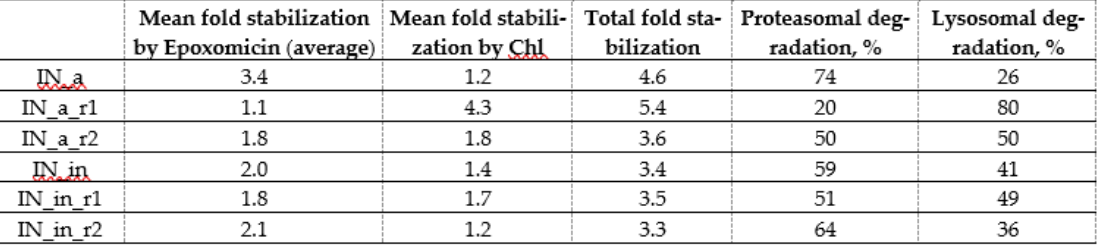
Figure 3. Proteolytic degradation of IN variants. Half-life of IN variants determined by pulse-chase ( a ); degradation pathway probed using proteasome ( b ) and Lysosome ( c ) inhibitors; proportion of proteasomal and lysosomal degradation patterns in the overall IN degradation ( d ). HeLa cells were transiently transfected with pVaxIN_a, or pVaxIN_a_r1, or pVaxIN_a_r2, or pVaxIN_in, or pVaxIN_in_r1, or pVaxIN_in_r2, and subjected to cycloheximide chase to determine half-life ( a ), or 48 h post-transfection treated with proteasome inhibitors MG132 (10 µ M) or Epo (0.5 µ M) ( b ), or lysosome inhibitors chloroquine (Chl; 10 µ M), leupeptin (Leu; 10 µ g/mL), aprotinin (Apr; 100 µ g/mL), pepstatin (Pep; 5 µ g/mL), or E-64 (10 µ М ), or left untreated (“Untr”) ( c ). Graphs ( b , c ) demonstrate the relative amount of IN protein in samples incubated with MG132 and epoxomicin ( b ) or with chloroquine (( c ), left panel) or with inhibitors of individual classes of proteases active in the lysosomal compartment represented as a pile-up of the effects of individual inhibitors (( c ), right panel) compared to the untreated samples. ( d ) Size of the circles is proportional to the total increase in the content of IN variants achieved after application of proteasome (Epo) and lysosome (Chl) inhibitors (total fold stabilization). Sectors of the circles show contributions of Epo and Chl inhibitors to the total stabilization of each IN variant, in %. The values used for the plotting of pie diagrams are indicated in the table below. Data represent the results of at least three independent experiments. IN variants demonstrated no significant difference in half-life in the CHI ( a ), or in response to treatment with MG132 versus Epoxomicin ( b ), or in response to treatment with Chl as compared to sum of treatments with individual inhibitors of lysosomal proteases ( c ) ( p > 0.05, Mann–Whitney test). *— p < 0.05, **— p < 0.01, difference between individual IN variants indicated on ( b , c ). The differences that were not shown on the ( c ) for the IN variants treated with Chl: IN_a_r2 versus IN_in_r2, p < 0.05; [IN_a, IN_in, and IN_in_r2] versus [IN_a_r1, IN_a_r2, and IN_in_r1], p < 0.01; IN_a_r1 versus all